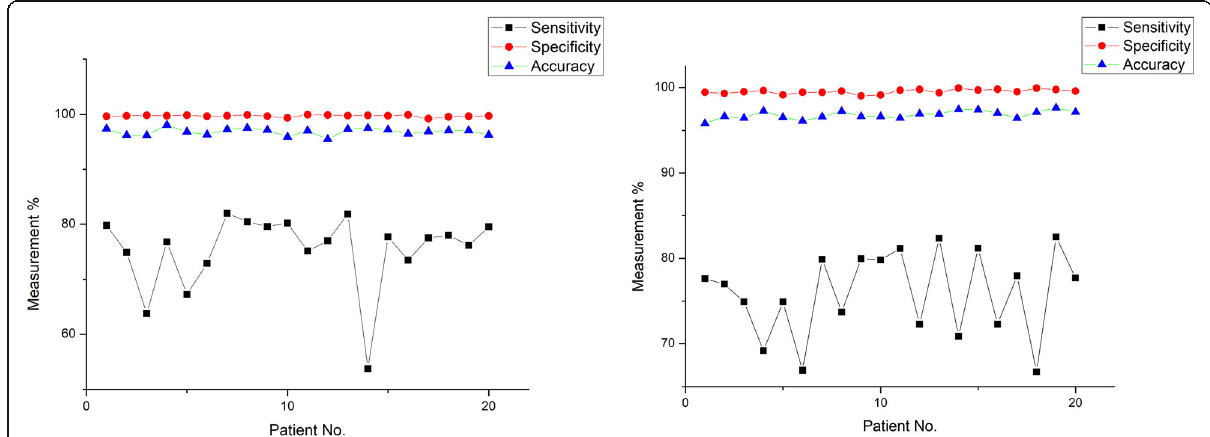
Fig. 8 Results of sensitivity, specificity and accuracy for MRI images using the modified DRLSE for atrophy and normal